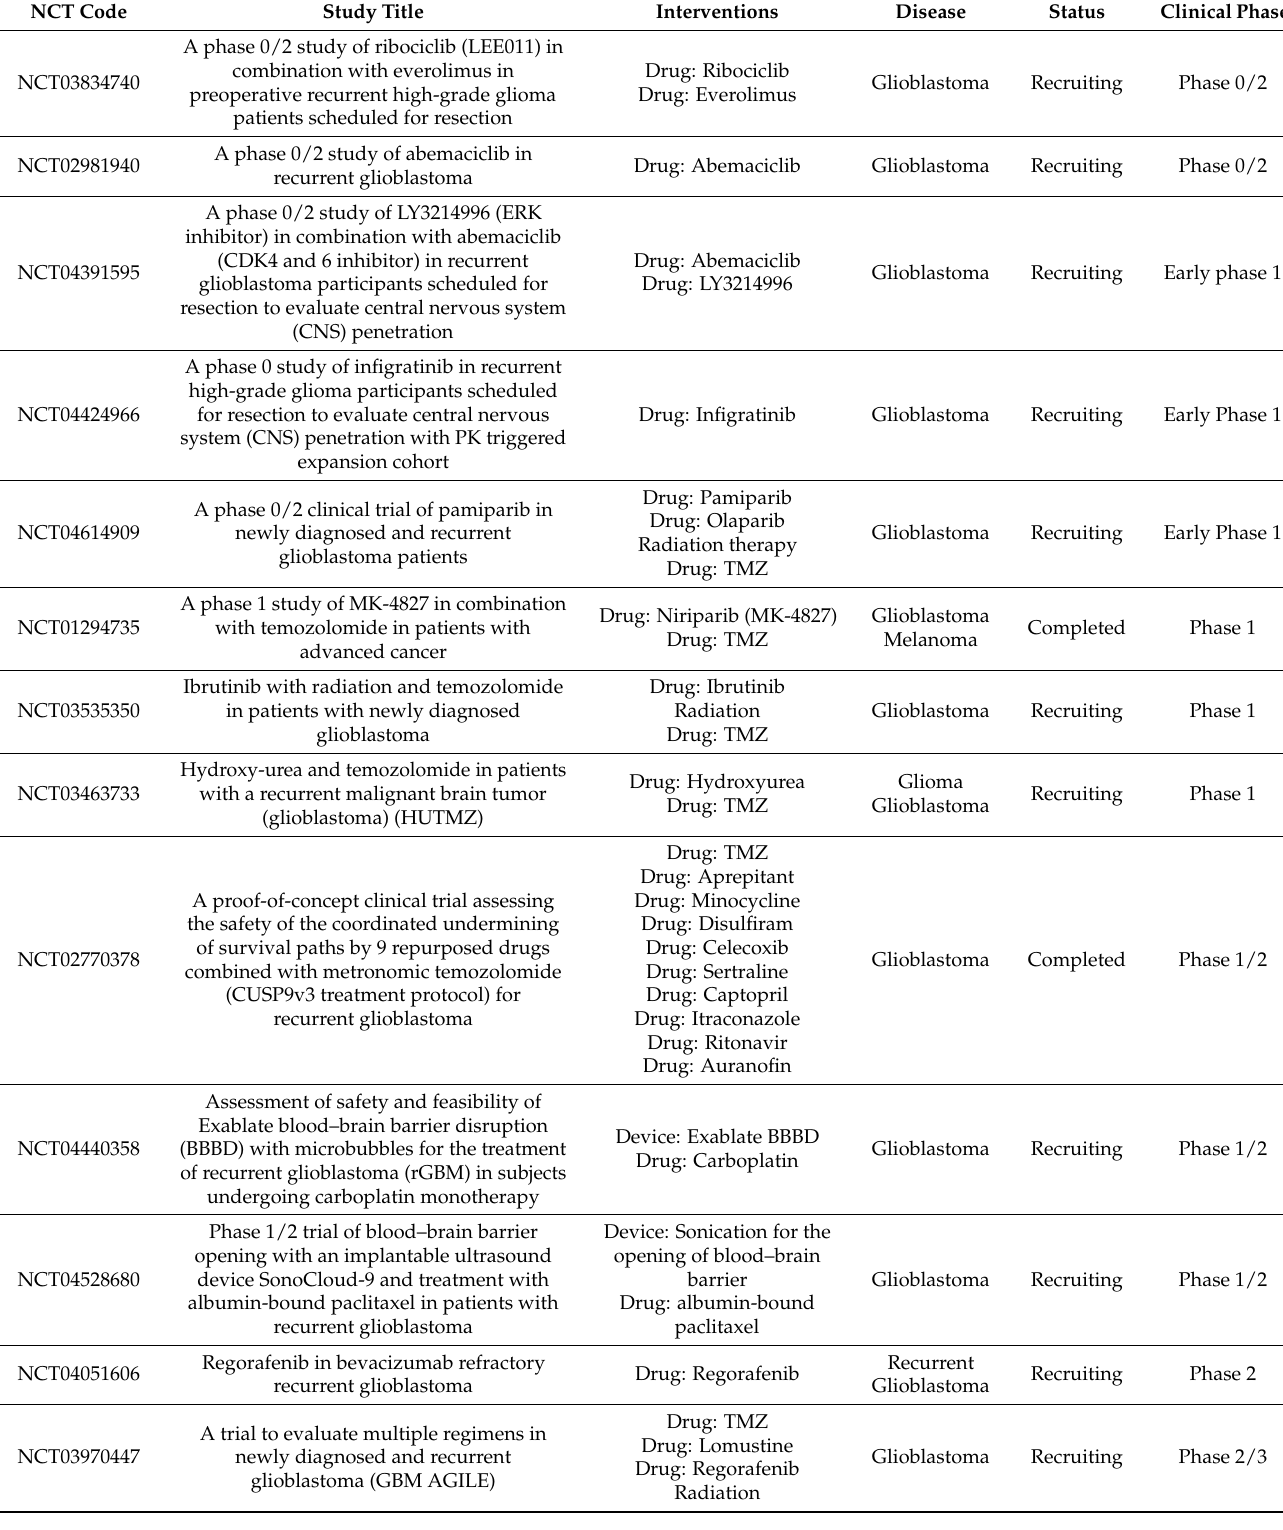
Table 2. Repurposed drugs under clinical investigation in